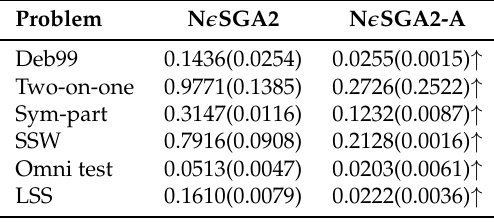
Table 3. Averaged ∆ 2 in objective space for the use of the external archiver and the base